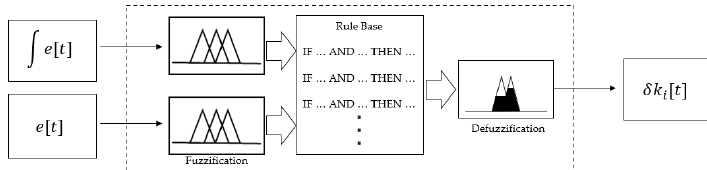
Figure 12. Structure of the Integral Controller Fuzzy Inference System.